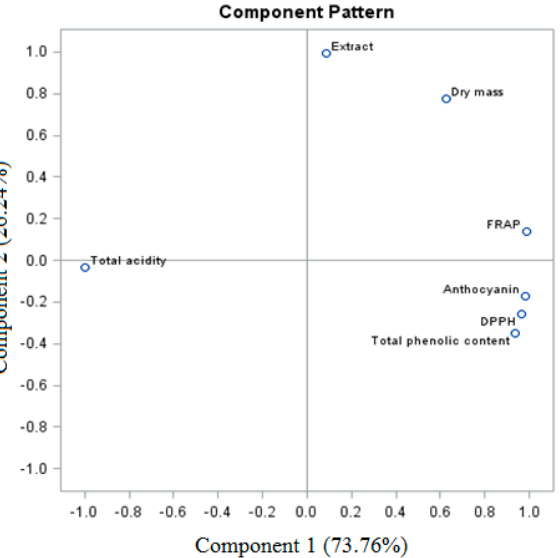
Figure 4. PCA analysis of fresh ‘Einset Seedless’ fruits against biologically active compounds.